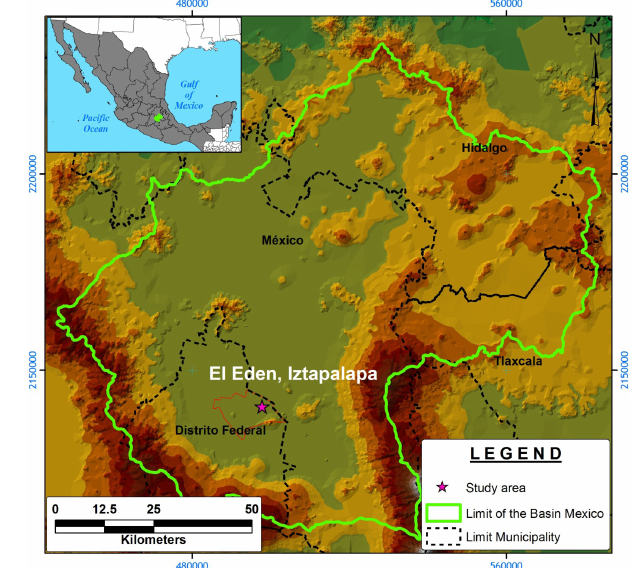
Figure 1. Location of the Mexico basin (in green) in the central part of Mexico. Whithin the Basin of Mexico is located the Mexico City (blackk dotted line, also called Distrito Federal) and the Izta- palapa municipality (red line). The location of “El Eden” Study Site is shown with a magenta star.